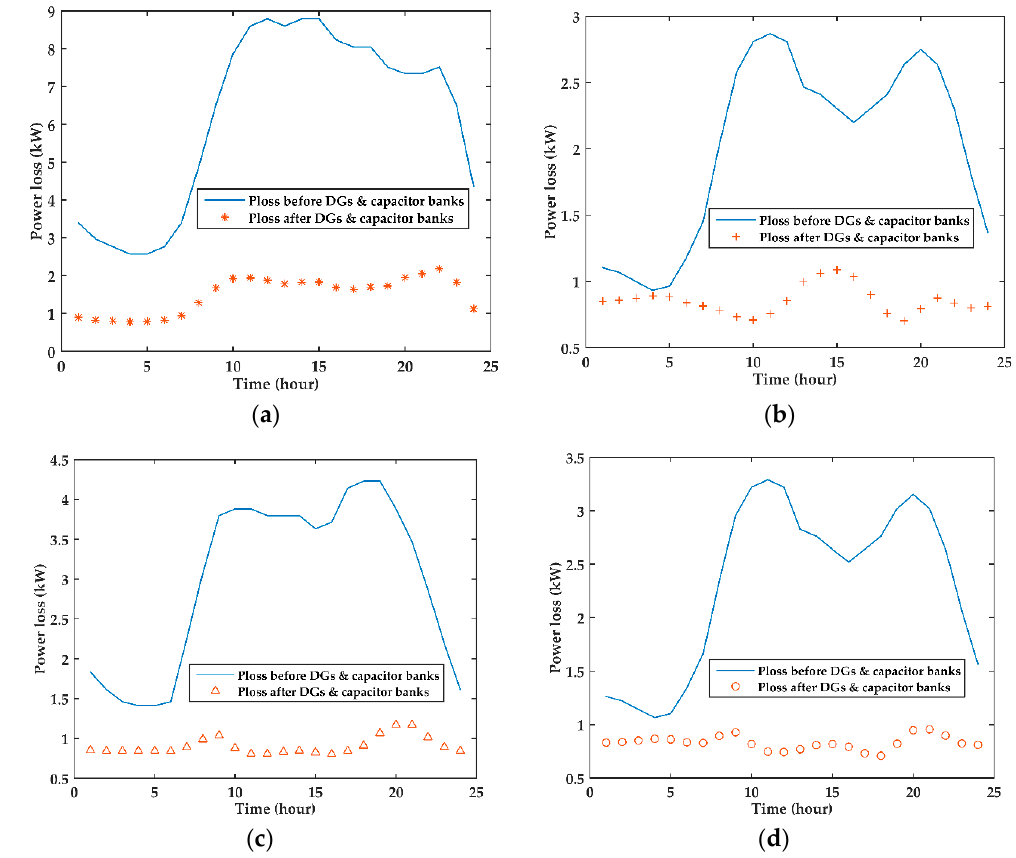
Figure 9. ( a ) Summer; ( b ) autumn; ( c ) winter and ( d ) spring average power losses before and after installation DGs and capacitor banks.